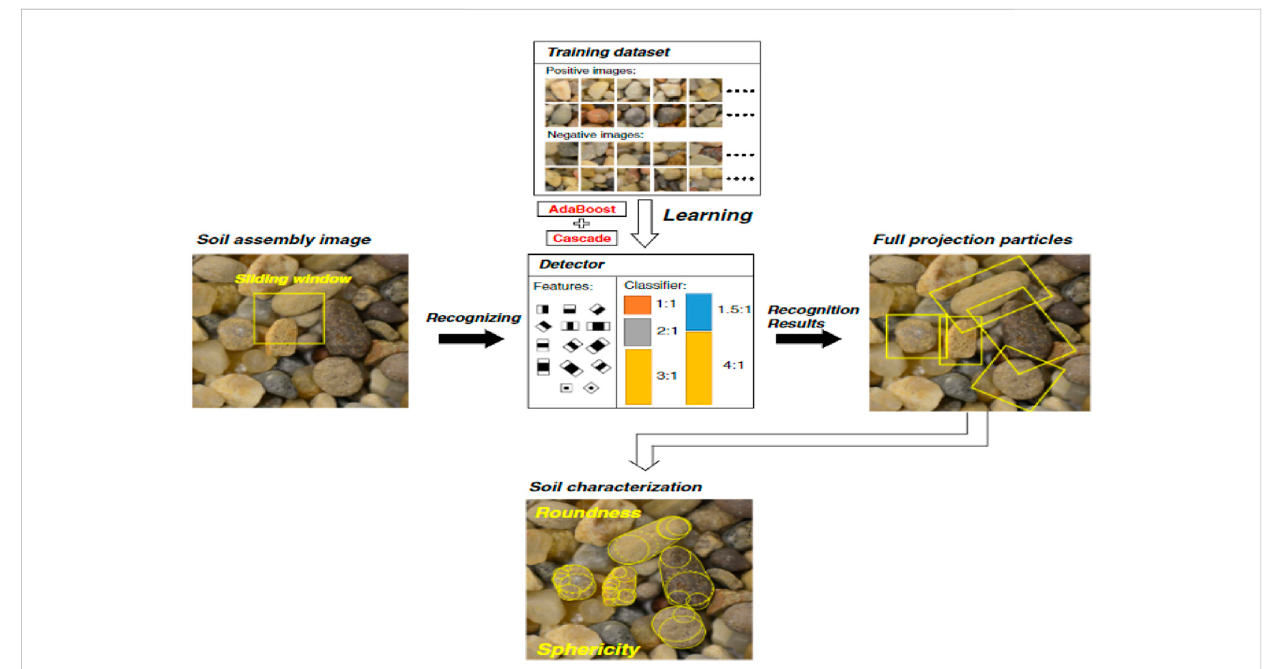
FIGURE 5 Method of pattern recognition for shape characterization, from (Zheng and Hryciw,